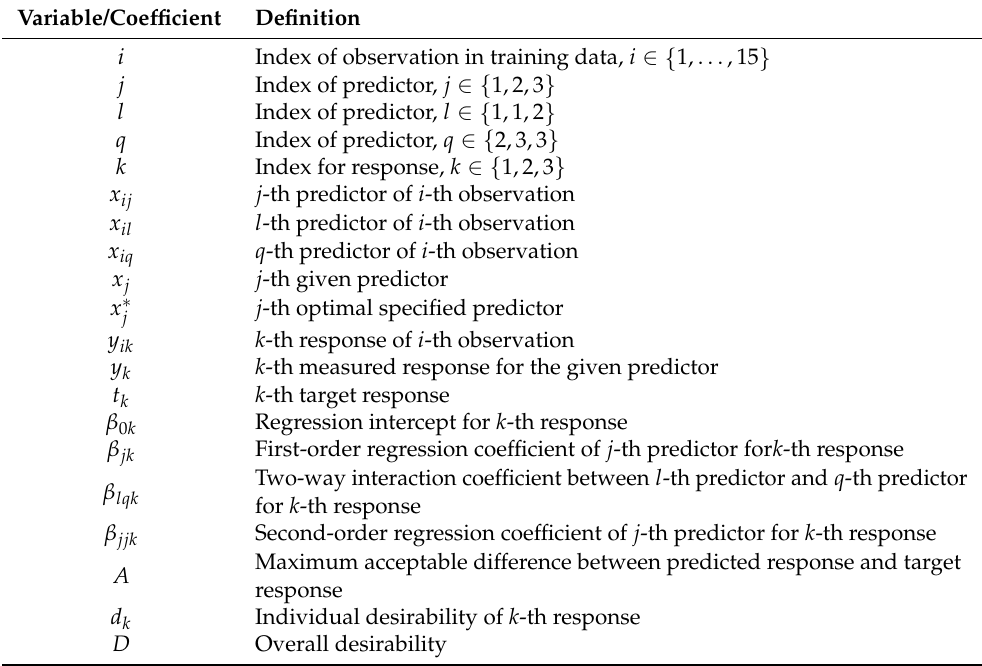
Table 2. Definitions of variables and